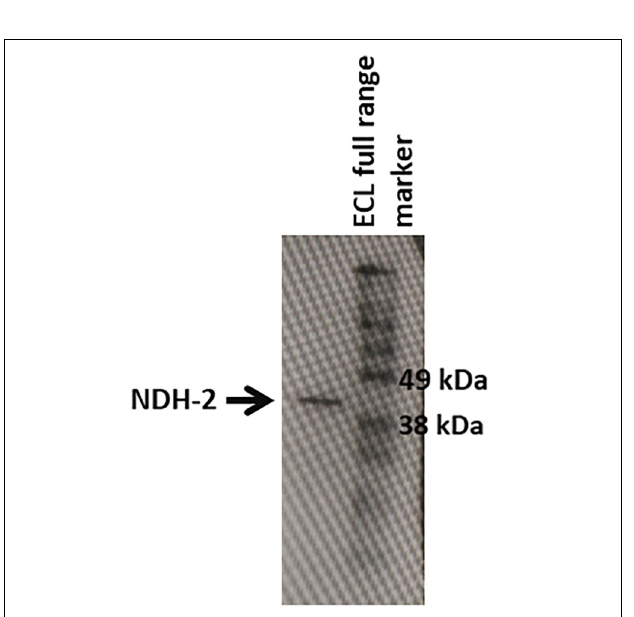
FIGURE 3 | Western blotting of the NDH-2 protein using anti-6X his antibodies. Prescence of band indicates the prescence of the NDH-2 in the membrane fraction.